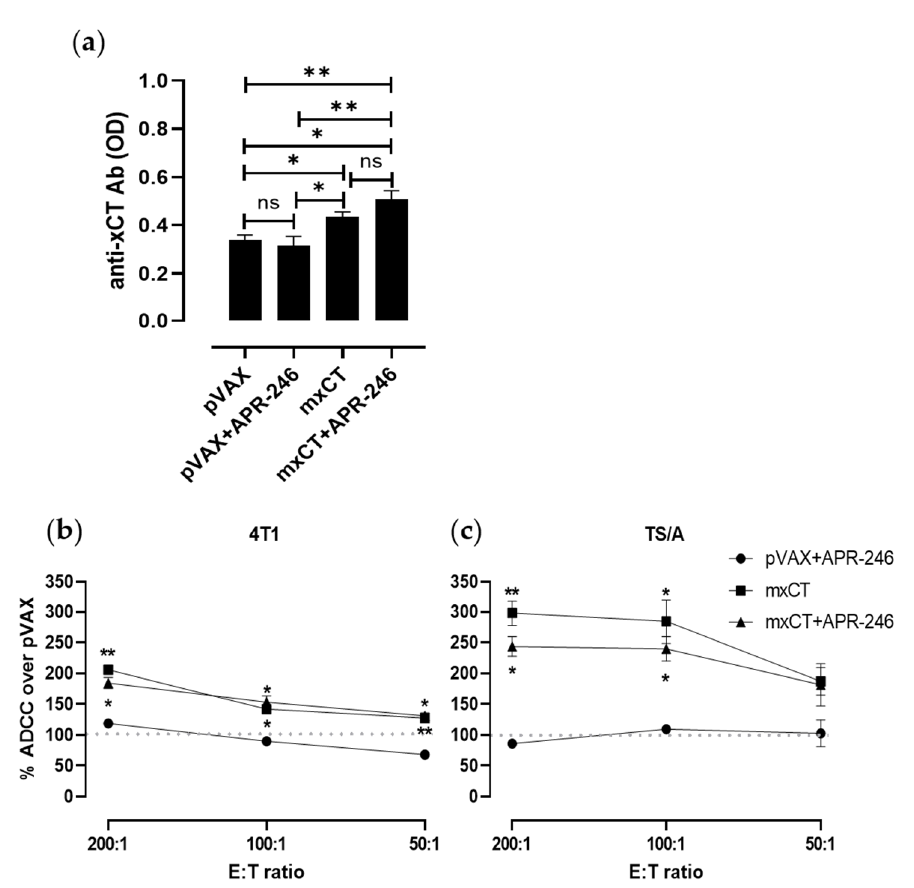
Figure 6. Immune response upon anti-xCT immunization in combination with APR-246: ( a ) Detection of vaccination-induced anti-xCT antibodies by ELISA in sera collected from the indicated groups of mice. Results are shown as mean ± SEM of optical density (OD) values obtained in triplicate. In vitro ADCC assays performed in the presence of serum from mice immunized with mxCT alone or in combination with APR-246 using ( b ) 4T1 and ( c ) TS/A tumor cells as targets (T) and splenocytes from syngeneic BALB/c mice as effectors (E) (E:T ratio = 200:1; 100:1; 50:1). Results are expressed as referred to values of lysis recorded with pVAX control mice serum (dotted lines). * p ≤ 0.04; ** p ≤ 0.006. Student’s t